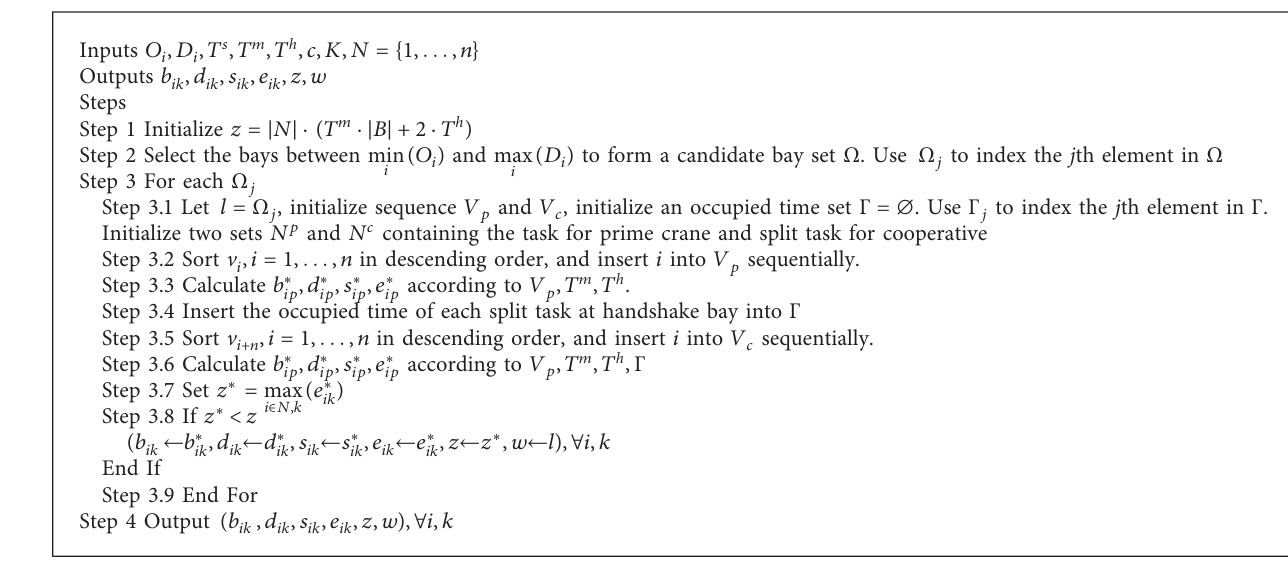
A LGORITHM 4: Decoding scheme based on crane